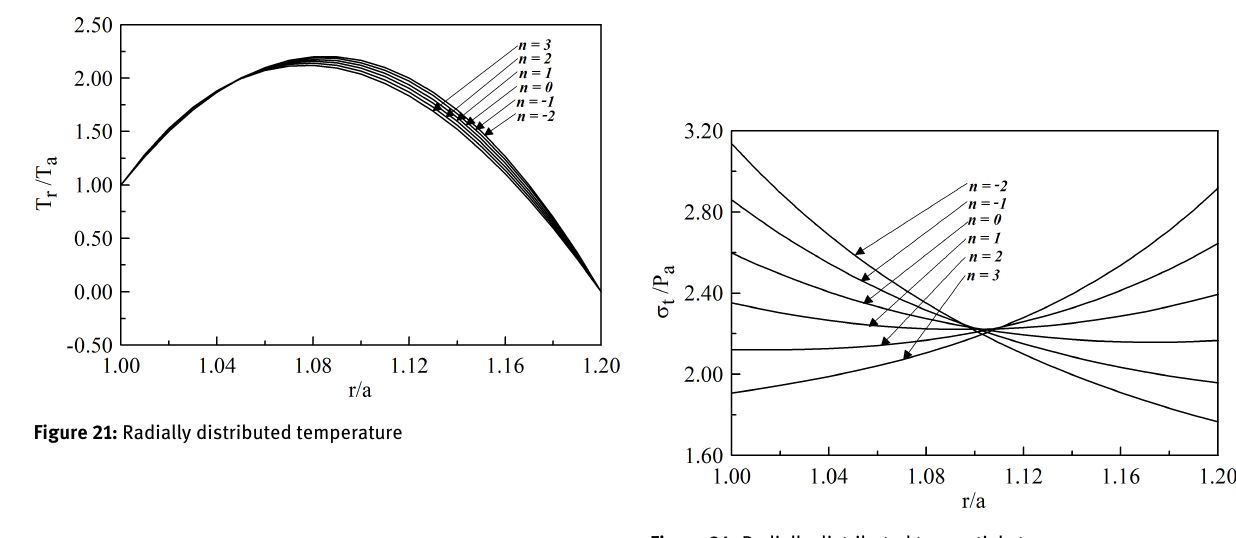
Figure 24: Radially distributed tangential stress